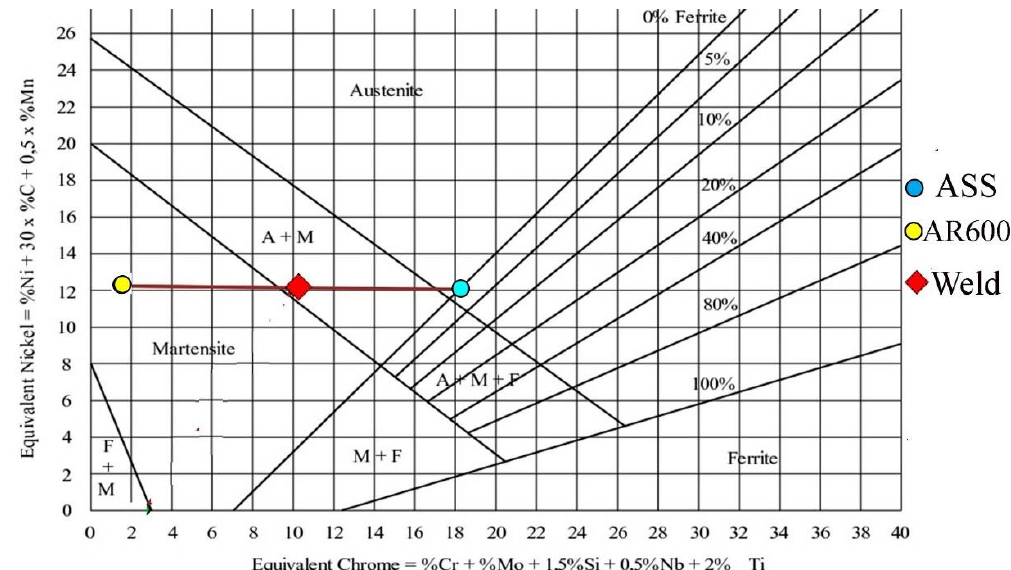
Figure 9. A Schaeffler diagram of the predicted structure of the studied dissimilar weld metal between austenitic stainless steel 301 and martensitic C-steel AR600 that is described in the current manuscript. The diagram was taken from [27].